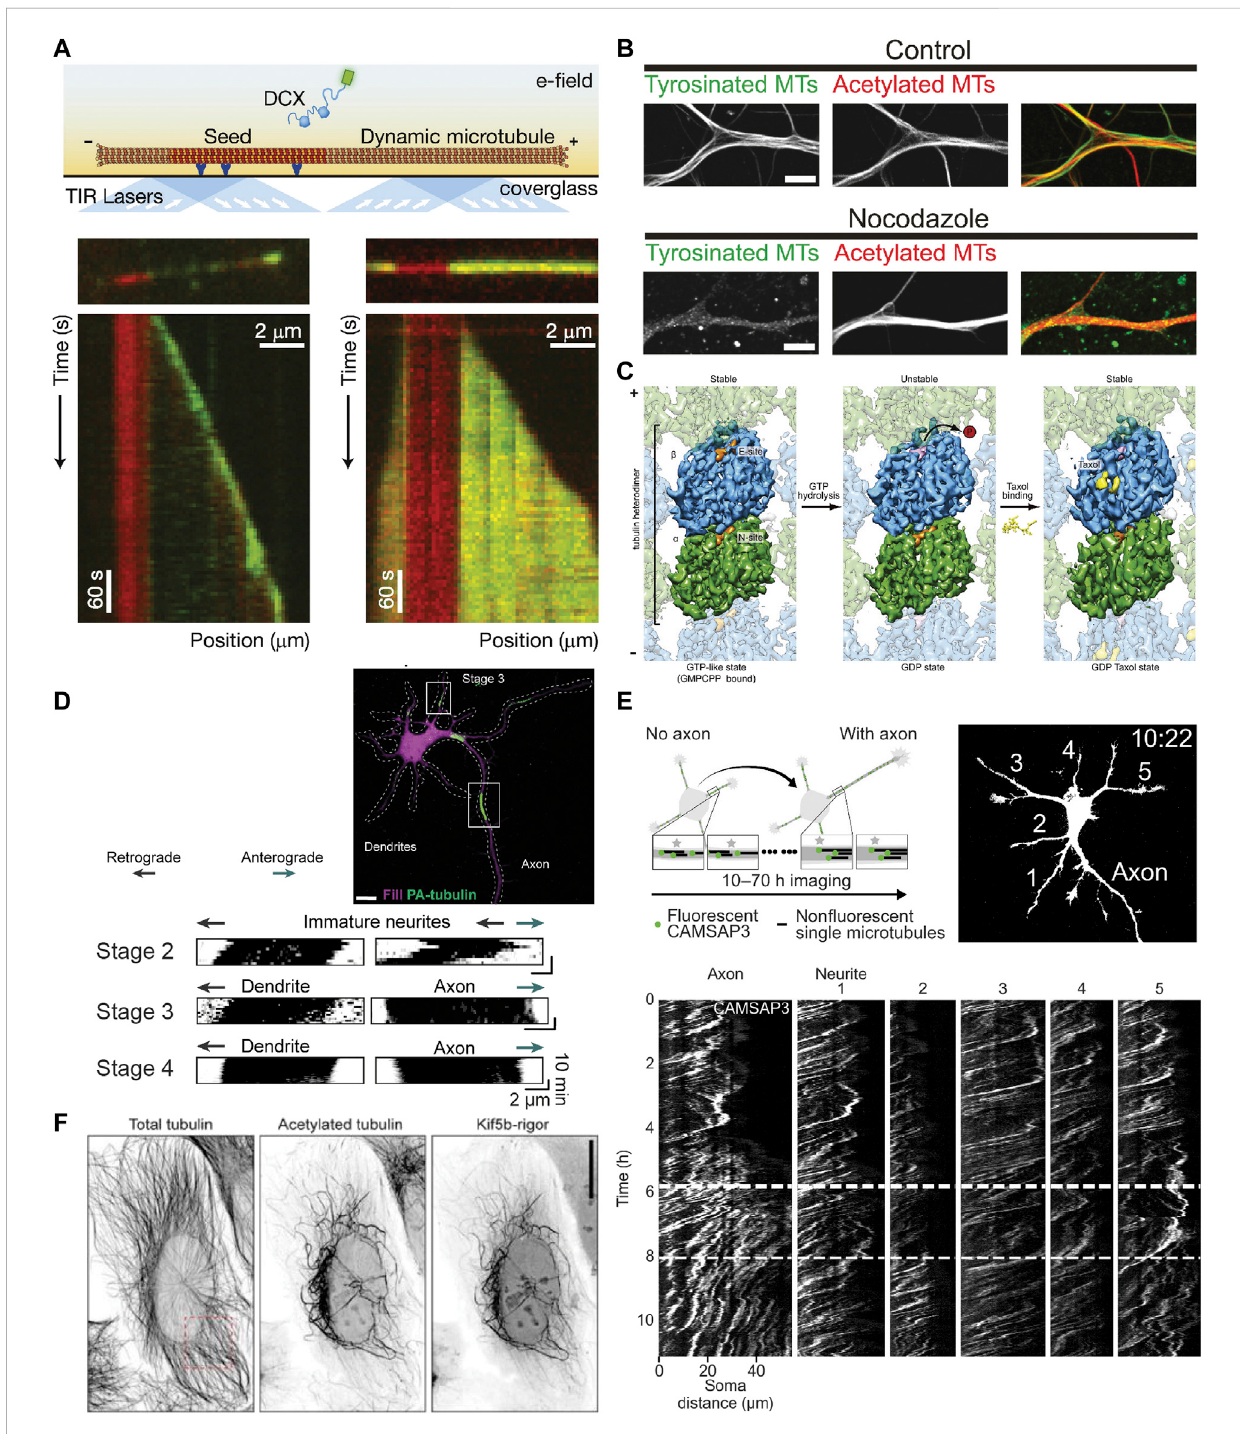
Methods for studying the properties of stable microtubules. (A) Schematic showing an in vitro assay to study microtubule dynamics and how it is affected by different MAPs. A microtubule seed stabilized with GMPCPP is immobilized via antibodies/streptavidin on an otherwise passivated coverslip and soluble tubulin (and in this case DCX) are added with GTP, such that the tubulin can undergo cycles of nucleated growth and shrinkage. Below are kymographs of two microtubules with the microtubule seed visible in red, and DCX visible in green at two different concentrations: 10 nM (left) and 100 nM (right). Interestingly, DCX shows different behaviours at these two concentrations. Taken from (Bechstedt and Brouhard, 2012). (B) Image showing tyrosinated and acetylated tubulin stainings in DIV9 rat hippocampal neurons in control conditions (left) or after a 2.5 h treatment with 4 µM nocodazole. Note how without the nocodazole treatment, the overall levels of the tyrosinated and acetylated microtubules is similar, but the low dose nocodazole treatment preferentially depolymerizes dynamic (tyrosinated) microtubules such that very little tyrosinated microtubule signal is present on the right, while the level of acetylated microtubules is less affected. Taken from (Tas et al., 2017). (C) Cryo-EM maps of tubulin within the microtubule lattice(viewedfromthelumen)withtubulinboundtoGMPCPP(aGTPanalog)(left),GDP(middle),orGDP+Taxol(right).Notethatoverall,theGMPCPP- bound tubulin and Taxol-stabilized tubulin look similar, having a longer lattice spacing (expanded conformation), while GDP-bound tubulin is more